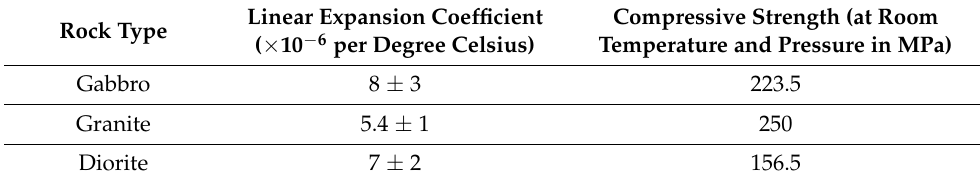
Figure 1. Rock specimens: ( a ) Before laser cutting and ( b ) after laser cutting. Table 1. The typical thermal and mechanical properties of rocks.